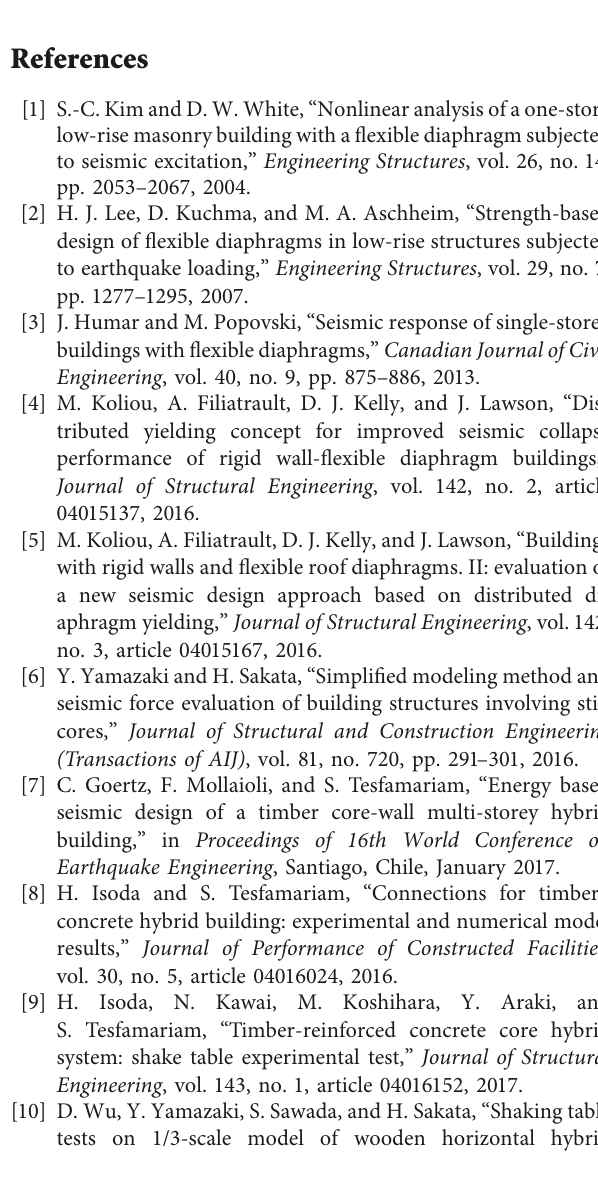
Figure 6: Peak shear force of the shear wall and diaphragm by DELF, MRS, and shaking table test results, PGA � 0.1g, unit: N. (a) Case 1: K s ≈ K d . (b) Case 2: K s � 10 K d